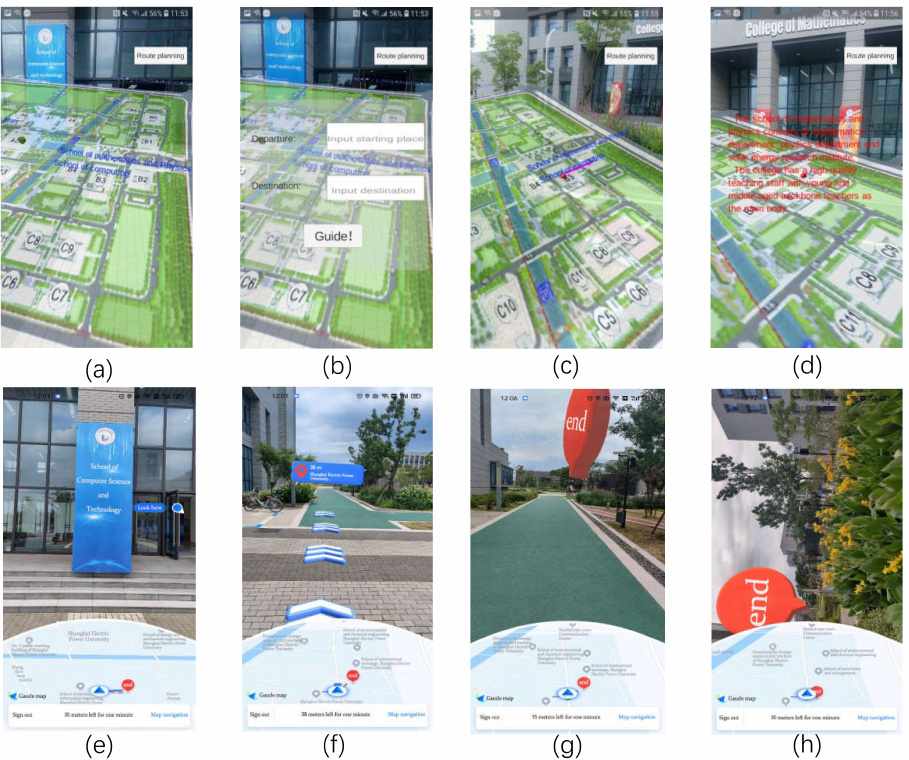
Figure 8. Interface collections of the proposed system ( a – d ) and Gaode AR system ( e – h ) in outdoor navigation. ( a ) Outdoor navigation initialization interface of the proposed system. ( b ) Navigation information input interface of the proposed system. ( c ) Navigation interface after route planning of the proposed system. ( d ) Augmented reality information of the proposed system after arriving at the destination. ( e ) Outdoor navigation initialization interface of Gaode map after input the destination. ( f ) Navigation interface after route planning of Gaode map. ( g ) The terminal mark of Gaode map. ( h ) Comparison of the terminal mark with the real destination directed by red